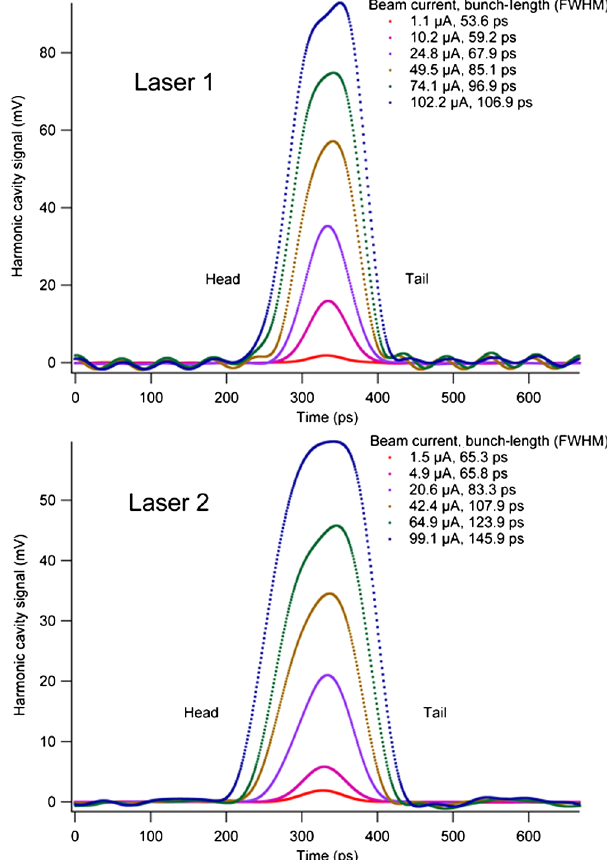
FIG. 5. Bunch-length plots using the harmonically resonant cavity for electron beams at 499 MHz using “ laser 1 ” with 45 ps optical pulsewidth FWHM (top) and 249.5 MHz using “ laser 2 ” with 60 ps optical pulsewidth FWHM (bottom), for different extracted beam currents. These plots were obtained by trans- forming the raw oscilloscope